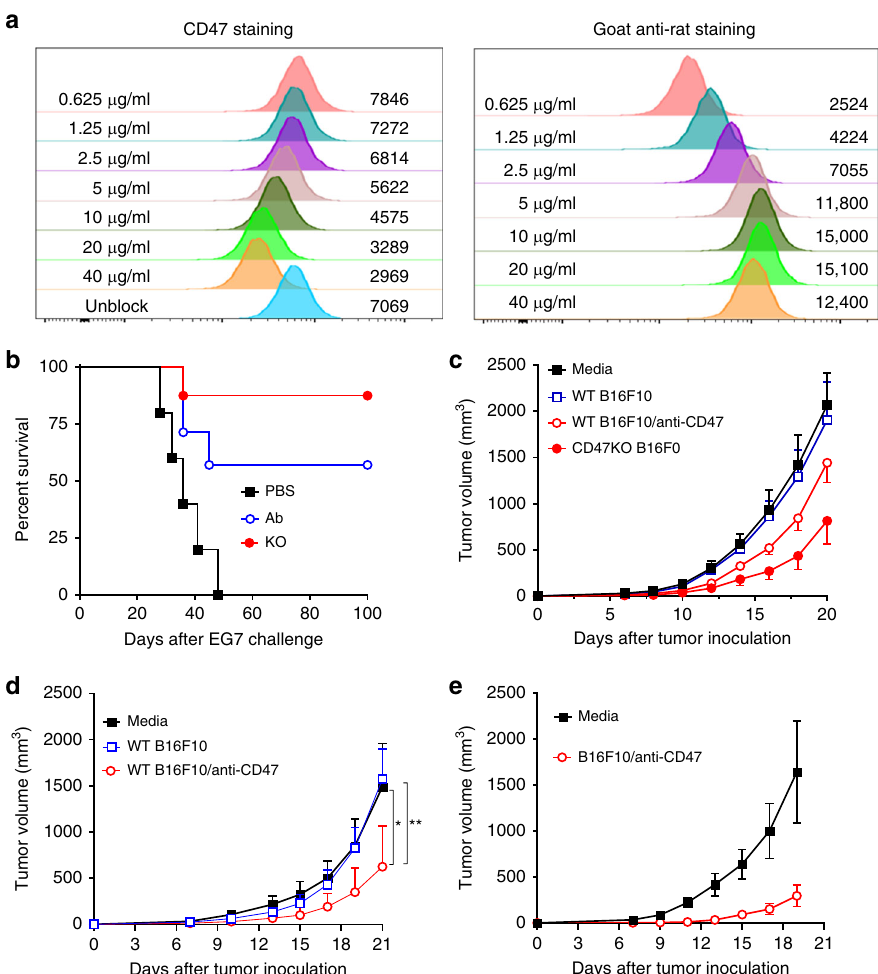
Fig. 3 Antitumor effects of anti-CD47 Ab-coated WT tumor or tumor TA-expressing cells. a Titration of anti-CD47 antibody for blocking CD47 on tumor cells. B16F0 WT cells were incubated with 2-fold serially diluted rat anti-mouse CD47 mAb MIAP301 (blocking; rat IgG) at 4 °C for 1 h, then stained